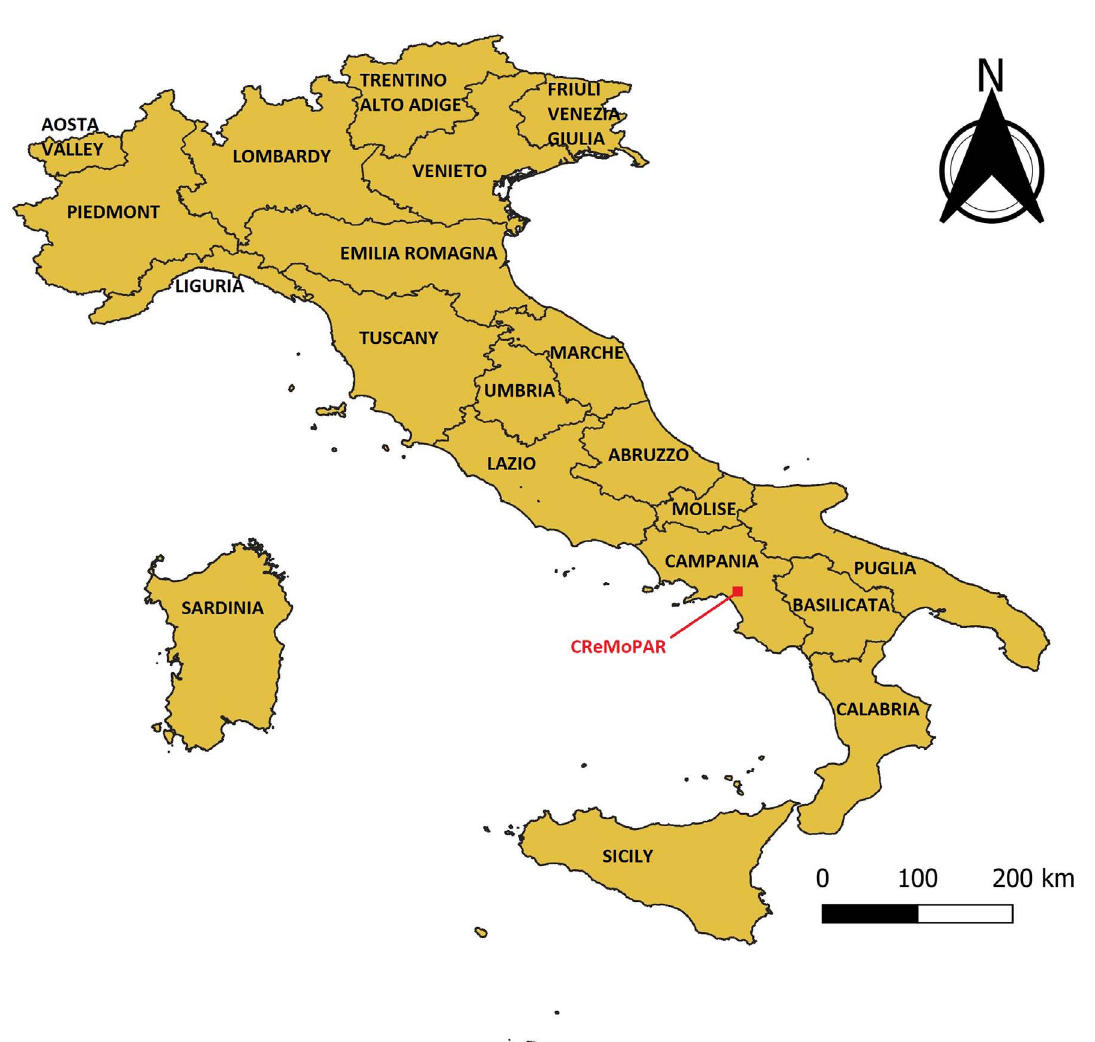
Figure 2. Administrative regions of Italy referred to in the 20 (cid:4) C depending on the region (http://koeppen-geiger. vu-wien.ac.at/).